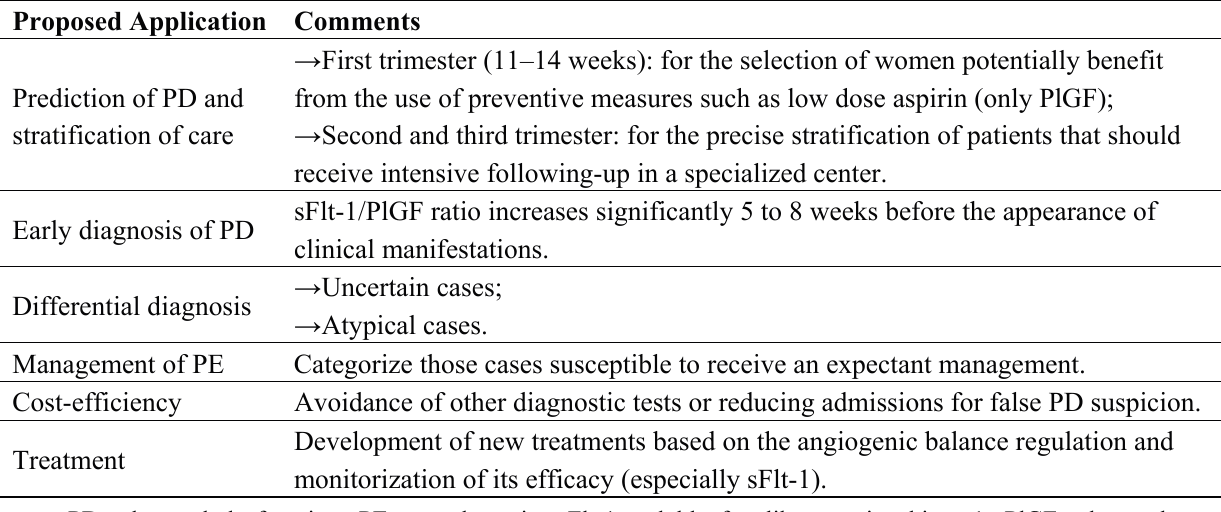
Table 1. Potential clinical applications of the angiogenesis-related biomarkers (sFlt-1/PlGF ratio) in placental dysfunction-related